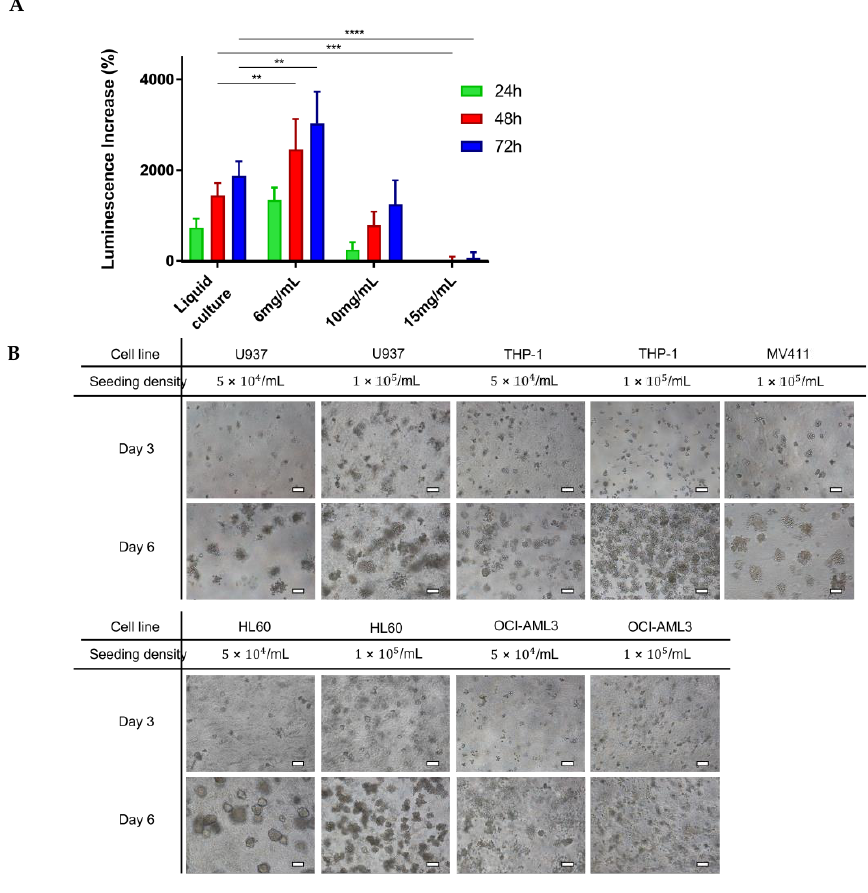
Figure 1. Human leukemia cell lines grow and form colonies in unmodified self-assembling peptide hydrogels (SAPH). ( A ) Cell viability assays determined by accrued luminescence measured by RealTime- Glo™; for U937 cells in increasing concentrations of hydrogel. Statistical significance (de- termined by two-way ANOVA in GraphPad Prism): ** p < 0.01, *** p < 0.001, **** p < 0.0001. N = 3, n = 3. ( B ) Phase-contrast images of human leukemic cell lines seeded at 5 × 10 4 /mL or 1 × 10 5 /mL in unmodified 6 mg/mL SAPH. Scale bars = 100